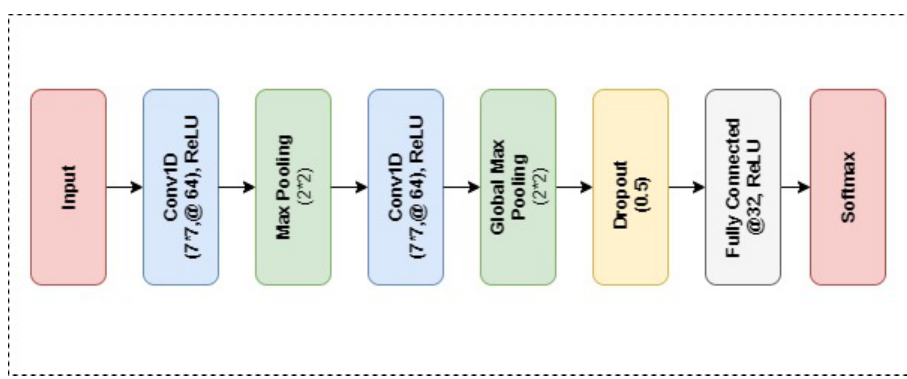
Figure 4. Layered Architecture of the Proposed CNN neural network.